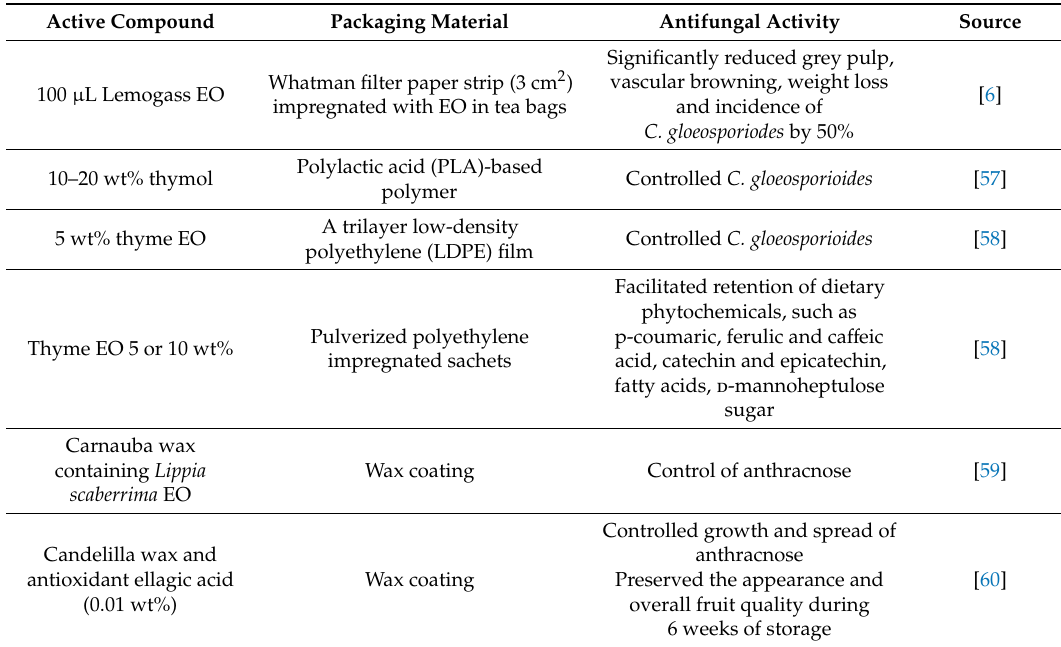
Table 4. Examples for antifungal waxes, film matrices and inserts for active packaging of